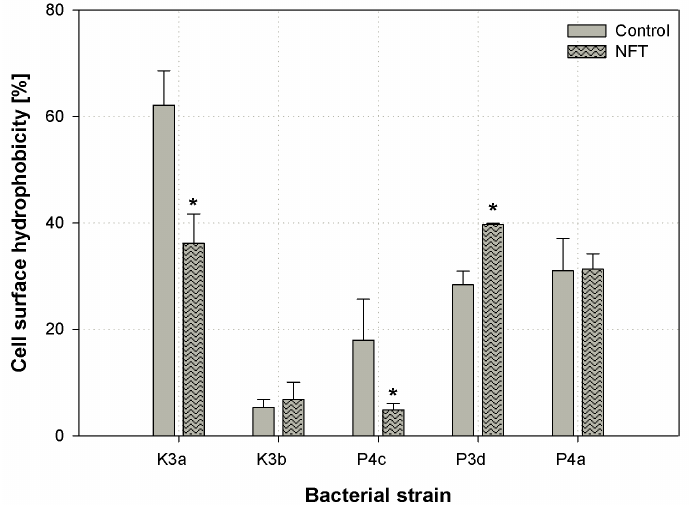
Figure 5. Changes in cell surface hydrophobicity in five microbial strains subjected and not subjected to contact with nitrofurantoin: Sphingomonas paucimobilis (K3a), Ochrobactrum antrophi (K3b), Rhizobium radiobacter (P4c), Pseudomonas aeruginosa (P4a), and Sphingobacterium thalpophilum (P3d); stars (*) above the columns indicate statistical differences among groups (samples treated with NFT vs. untreated controls, p < 0.05, ANOVA followed by Tukey’s range test); the results are reported as mean values calculated from three independent experiments.